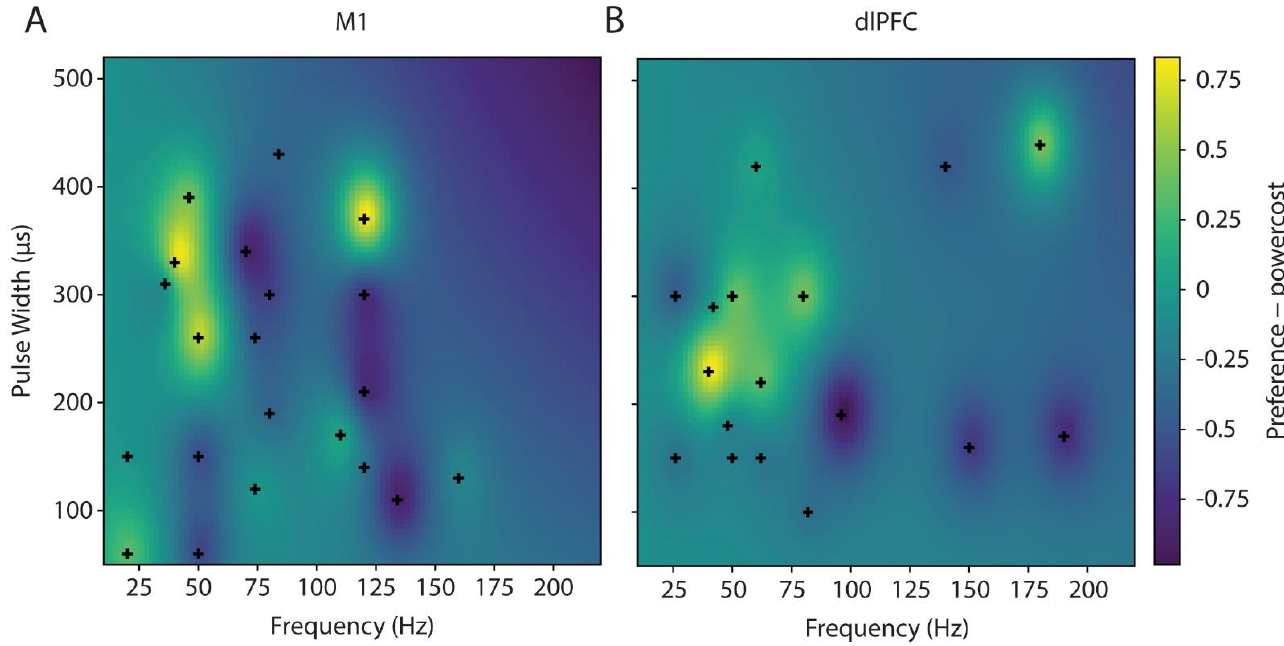
Figure 3. Frequency, pulse width, and amplitude (not shown) optimizations for single electrode combination in M1 on day 3 ( A ) and in dlPFC on day 4 ( B ). Yellower colors indicate preferred stimulation parameters, while bluer colors indicate non-preferred stimulation parameters.